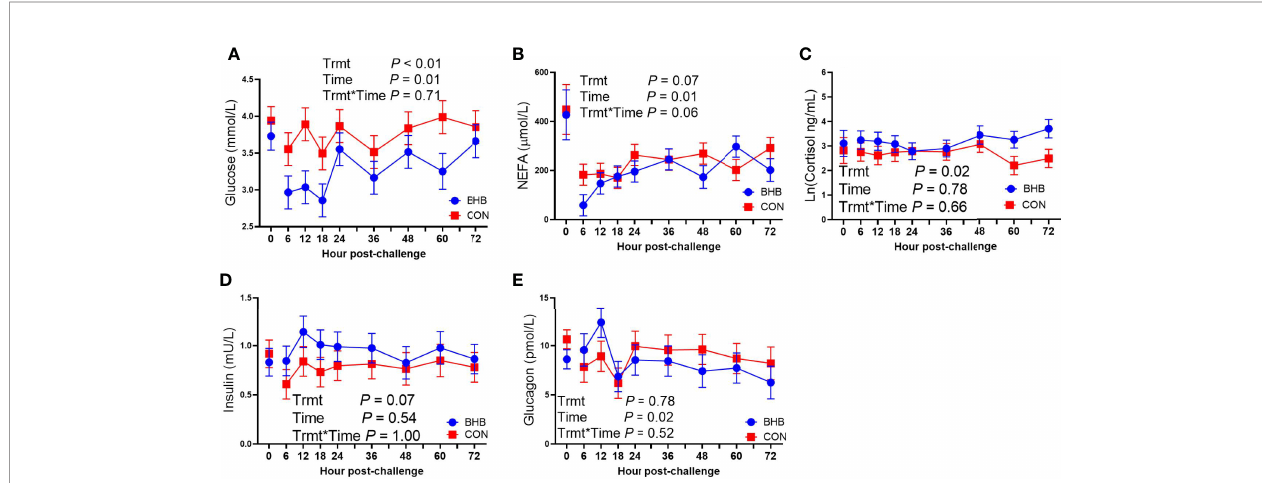
FIGURE 4 | Intravenous infusion of sodium b -hydroxybutyrate altered glucose metabolism during a Streptococcus uberis challenge. Late lactation multiparous cows (n = 12) were blocked by parity and milk yield and randomly assigned to either receive an intravenous infusion of 2.5 M Na-BHB to induce hyperketonemia or 2.5 M NaCl (CON) for 72 h. Infusion rates were adjusted to maintain a target concentration of 1.8 mM BHB in the BHB-infused cows. All cows were challenged with S. uberis in the right rear and right front quarters of the mammary gland at the start of the infusion. Blood samples were collected every 6 to 12 h during the 72 h infusion. Glucose (A) and nonesteri fi ed fatty acid (NEFA; B ) concentrations were determined using enzymatic colorimetric assays. Cortisol (C) , insulin (D) , and glucagon (E) were determined using a bovine-speci fi c ELISA. Data presented as LSM ±